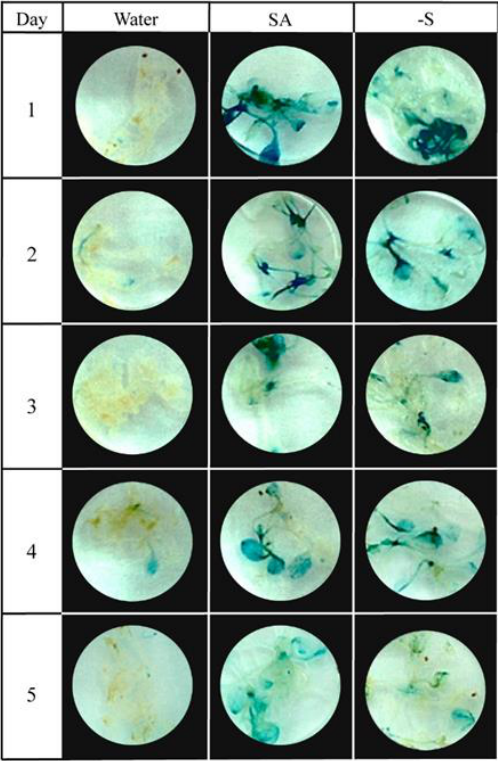
Figure 3. PR1 expression for the first five days after treatment application on 3-week-old PR1::GUS in vitro plants. The activation of PR1 with salicylic acid (SA) and sulfur deficiency (-S) was evaluated. Water treatment was used as a negative